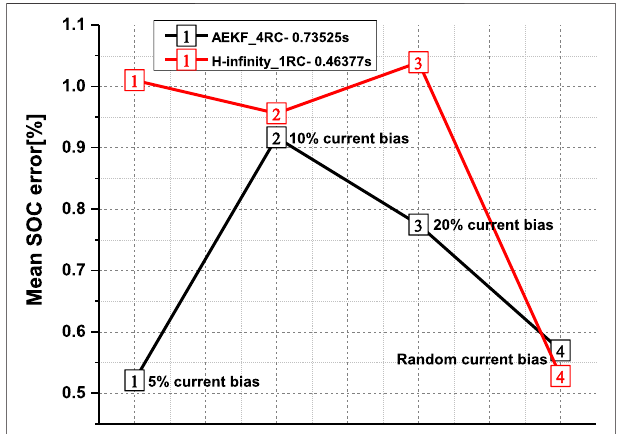
FIGURE 14 | Comparison results of the two estimators with varying current bias.